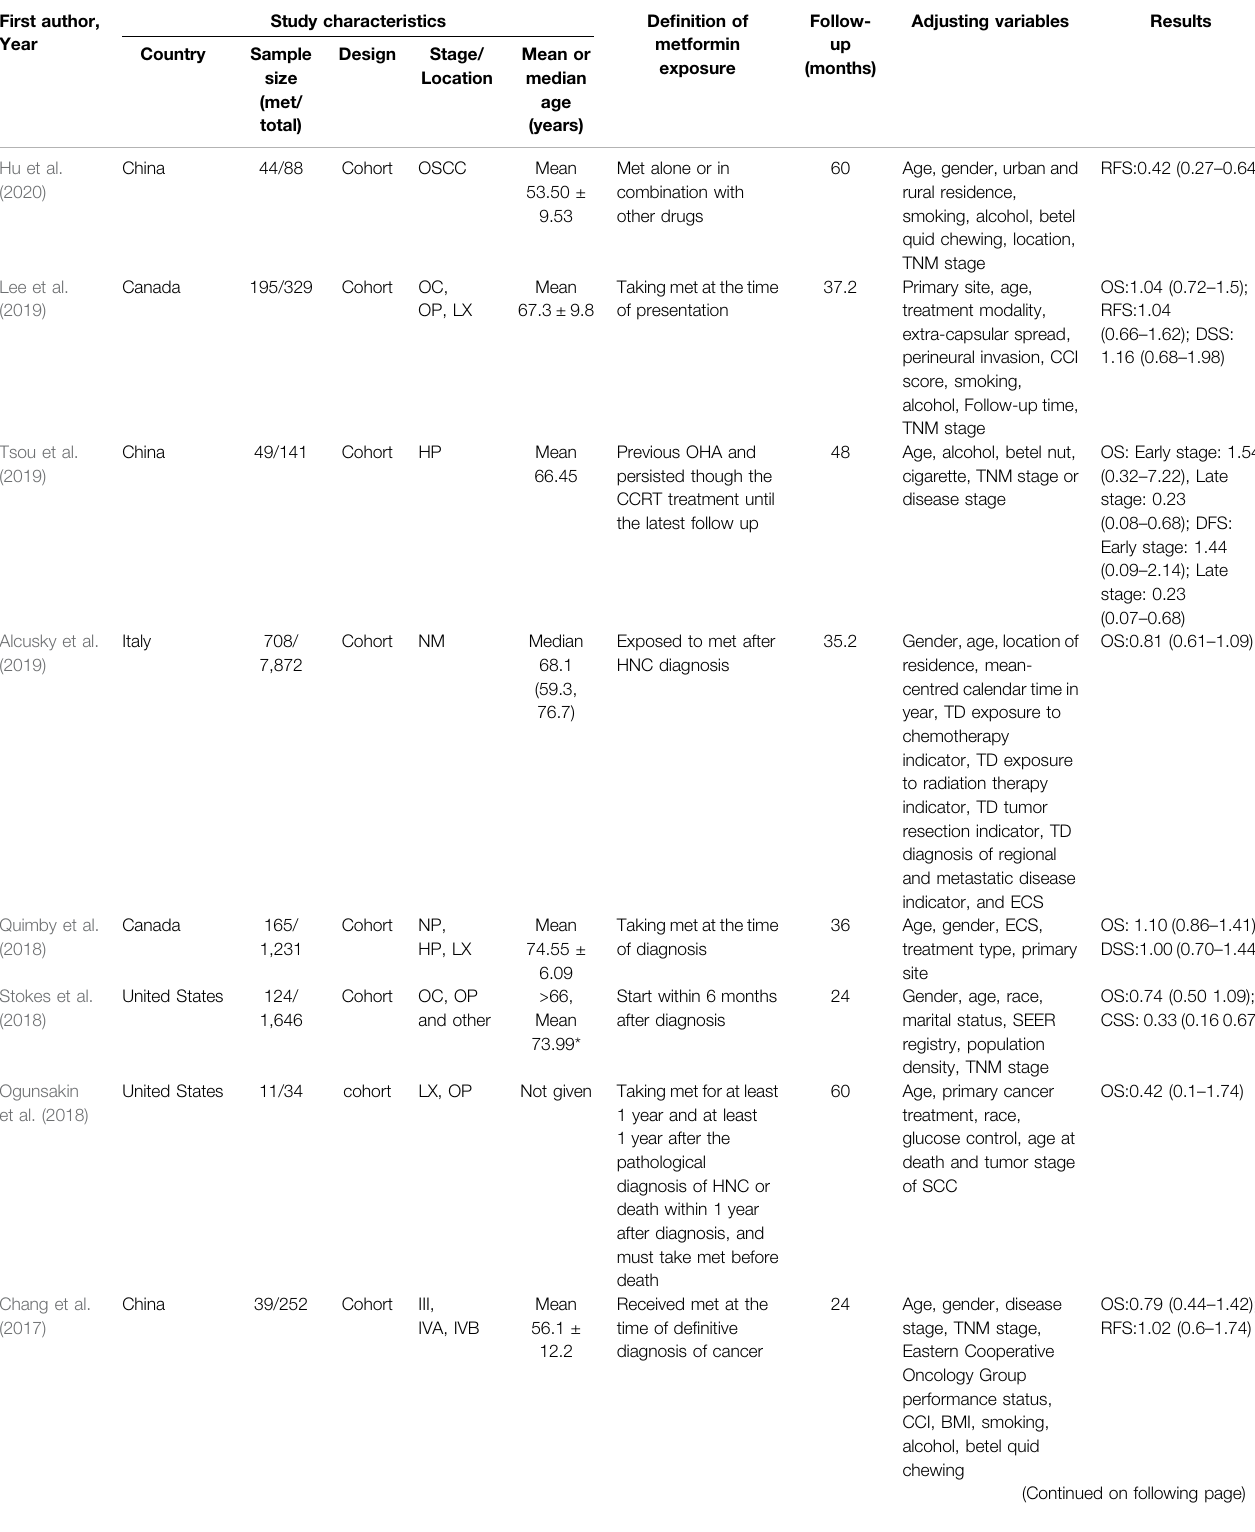
TABLE 1 | A summary of characteristics of the included